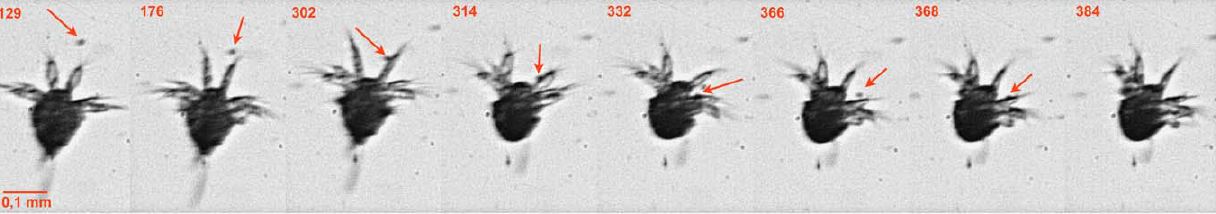
Figure 8. Prey capture in Temoralongicornis . Time series of still images with frame numbers indicated (consecutive frames are 0.45 ms apart). Arrows point towards the prey. In the last image the prey has been captured.